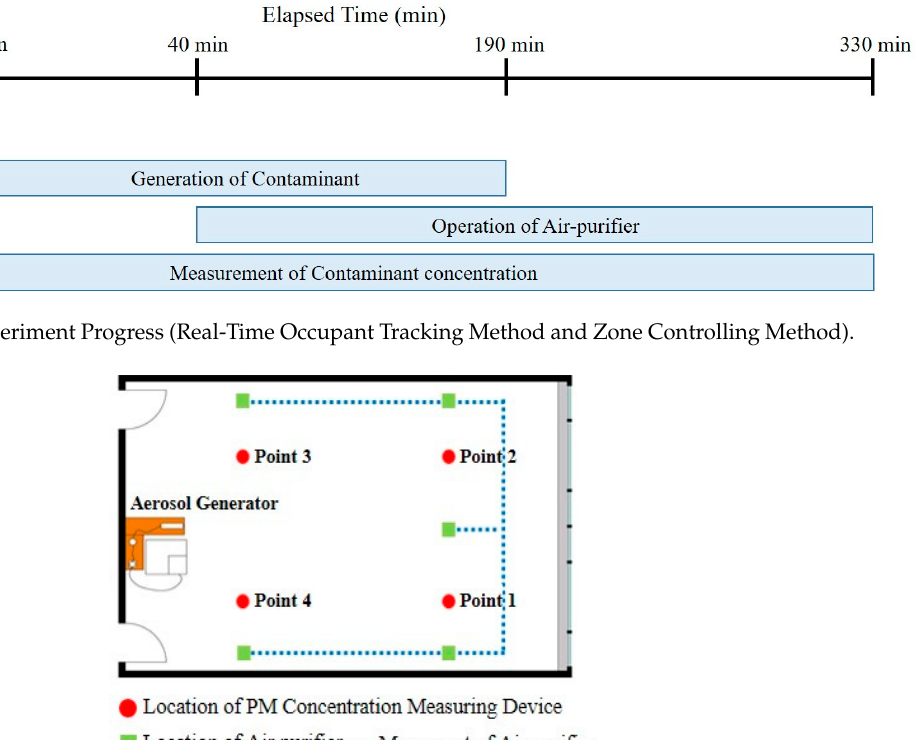
Figure 11. Experiment Progress (Real-Time Occupant Tracking Method and Zone Controlling Method) . Figure 12. Moving path of the air purifier that controls zones. Figure 12. Moving path of the air purifier that controls